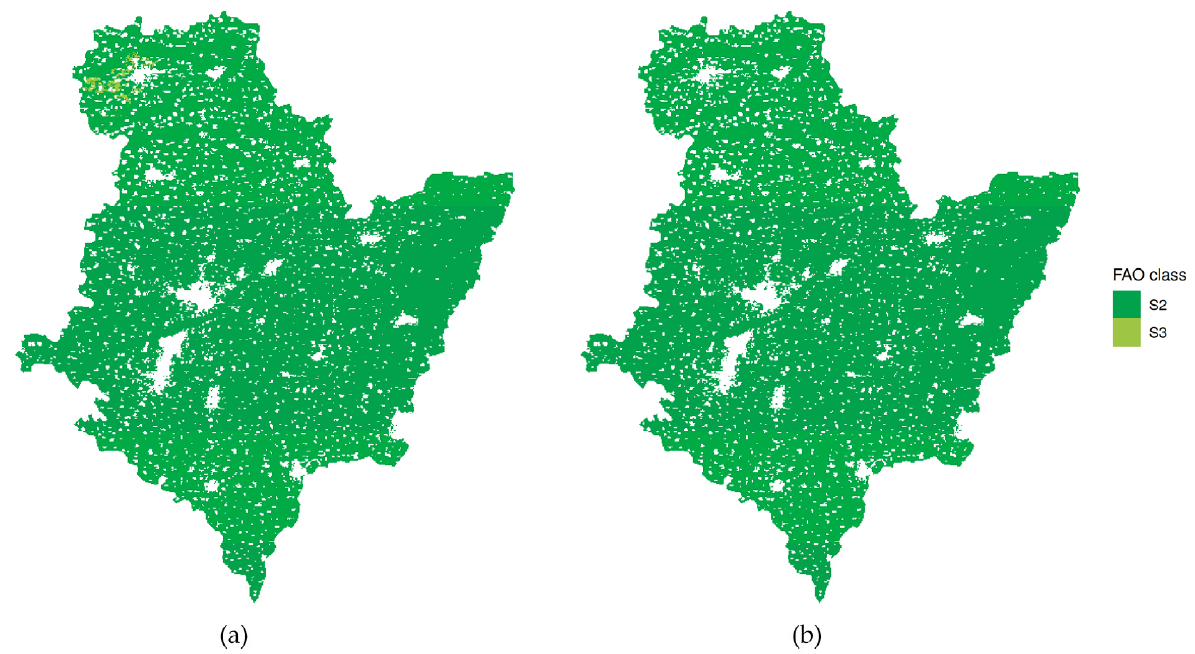
Figure 14. LS classes and validation after SICS implementation for maize in Hengshui: ( a ) Conservation Tillage (CT); ( b ) Cover Crop (CC); Crop Residue Management (CRM); Manure Application (MA) .